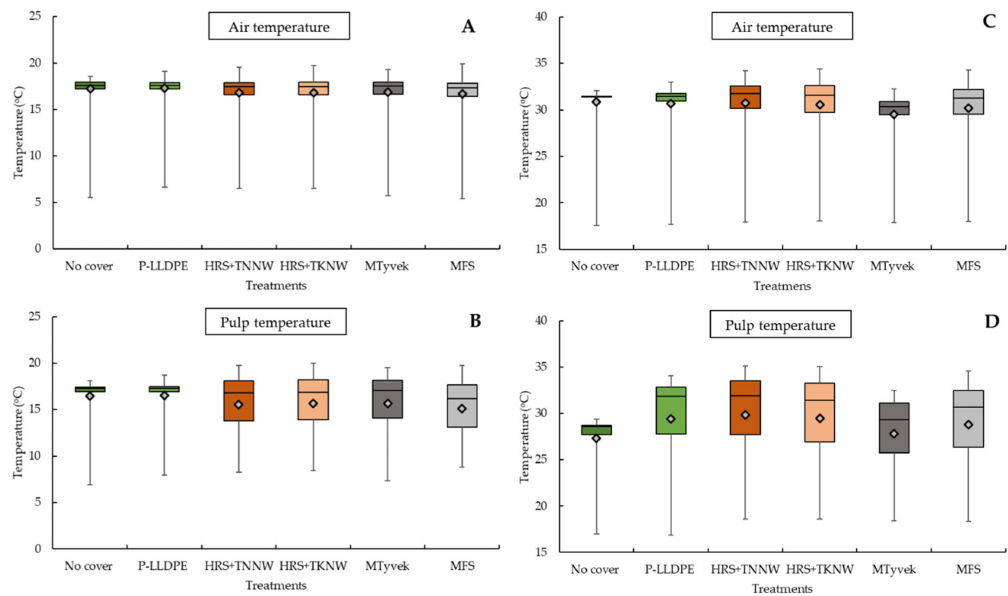
Figure 5. Boxplot of air ( A ) and pulp ( B ) temperature profiles during simulated storage at 18 ◦ C for 12 h. Air ( C ) and pulp ( D ) temperature profiles during simulated transportation at 30 ◦ C for 12 h. The lower and upper quartiles are represented by boxes. The horizontal line represents the median temperature in each box while the mean temperature is indicated by ( ♦ ). Minimum and maximum temperatures are presented by vertical lines extending above and below each box.